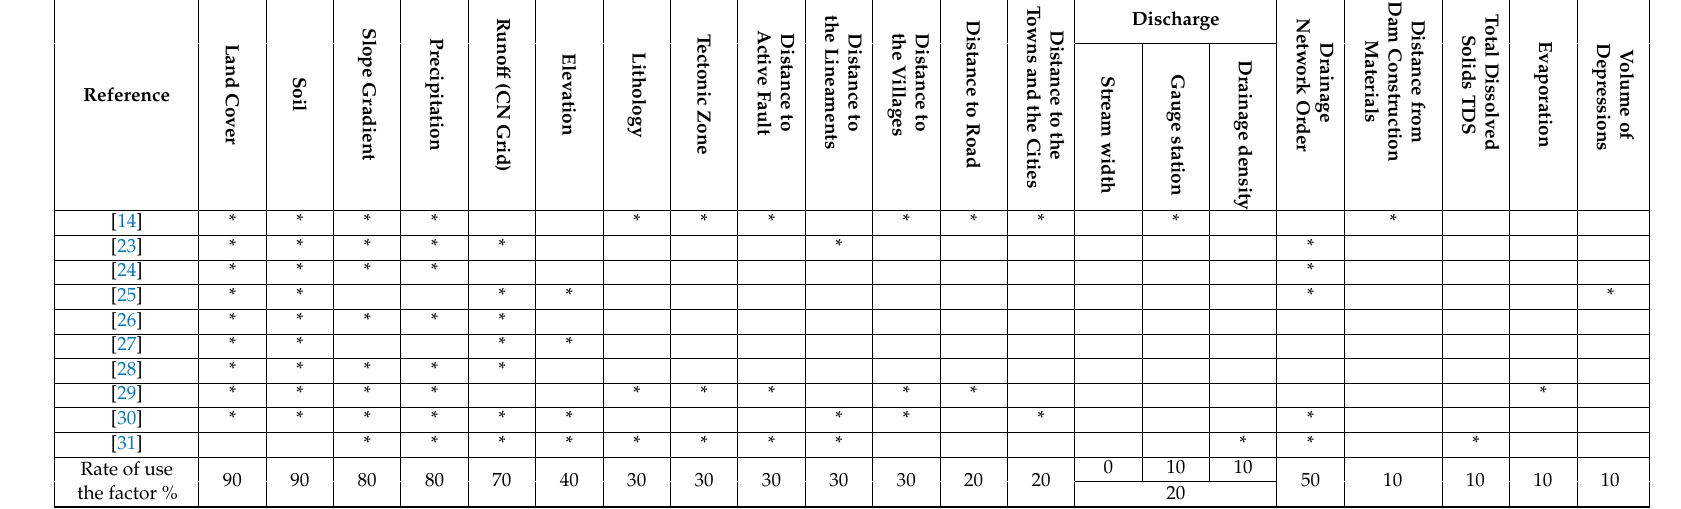
Table A2. Rate of the selected factors used for dam site selection in the KhRB versus all factors used elsewhere.